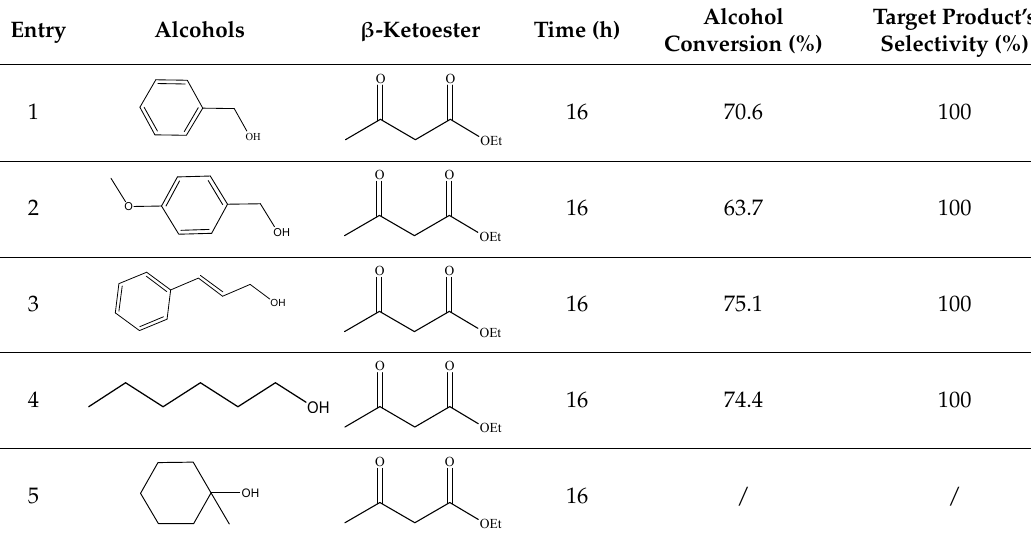
Table 5. Transesterification reactions catalyzed by BSNC-700-tBu (0.1 M).